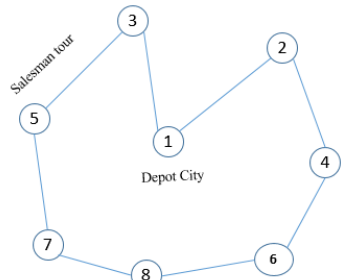
Fig. 1. An arbitrary 8 city TSP solution Fig. 2. An arbitrary 5 city TTSP